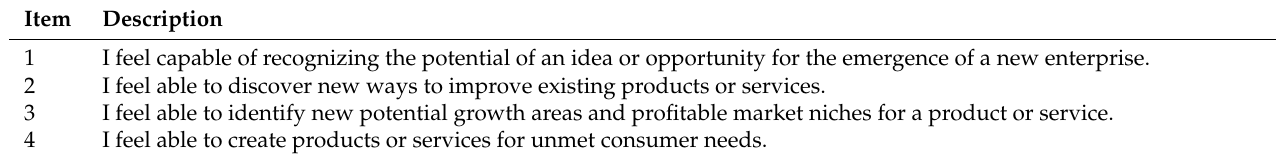
Table 3. Items of the entrepreneurial self-efficacy